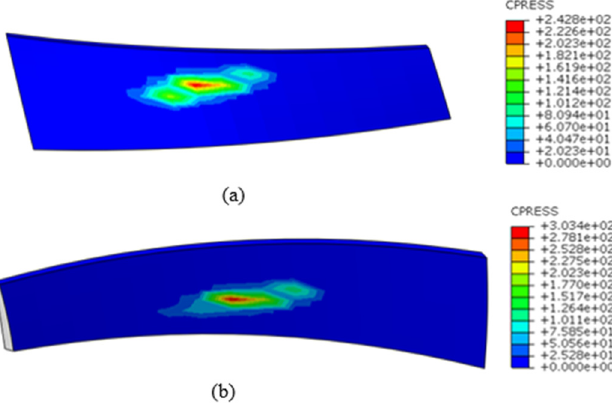
Fig. 9. Results of fi nite element analysis. (a) Convex side of gear. (b) Concave side of gear.